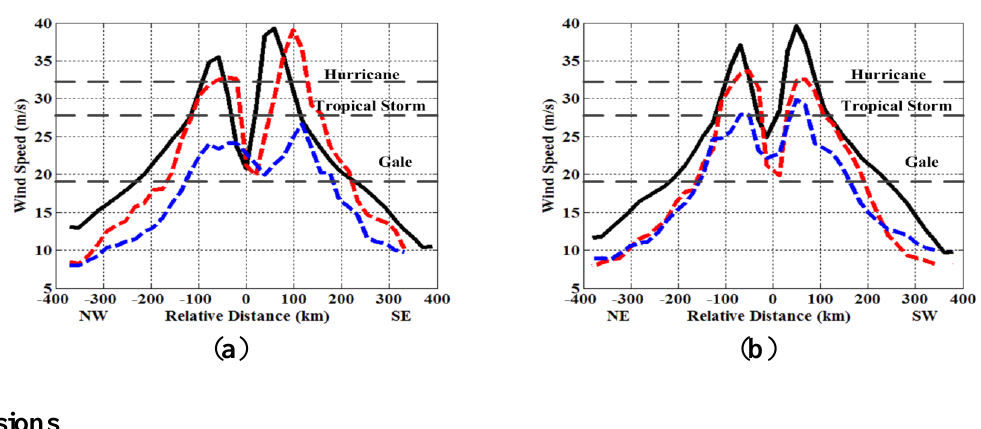
Figure 10. Radial wind speed profiles averaged by quadrant for Hurricane Bertha Rev. # 47194. Panel-a represents diagonal profiles from northwest to southeast, and panel-b represents diagonal profiles from northeast to southwest. Solid black lines are H*Wind, dashed red lines are X-Winds, and dashed blue lines are L2B-12.5